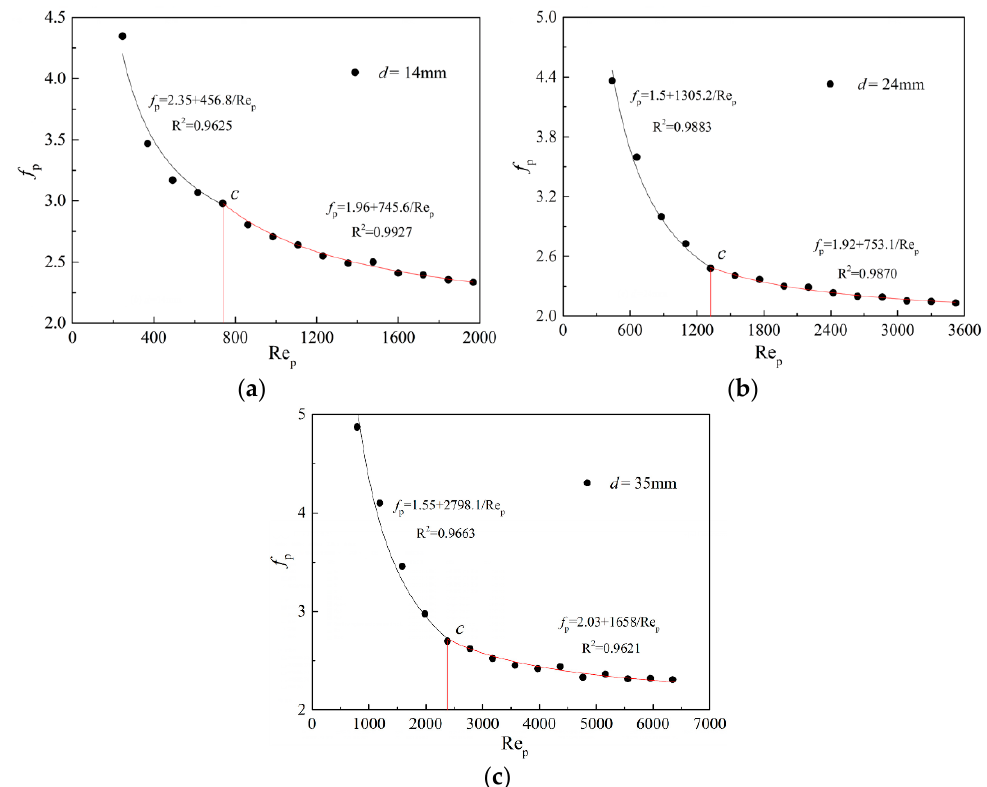
Figure 5. Quantitative relationships of the particle friction factor with the particle Reynolds number. ( a ) d = 14 mm; ( b ) d = 24 mm; ( c ) d = 35 mm. Table 2. Values of the modified coefficients α and β for different flow regimes. Forchheimer Flow Turbulent Flow Coefficients